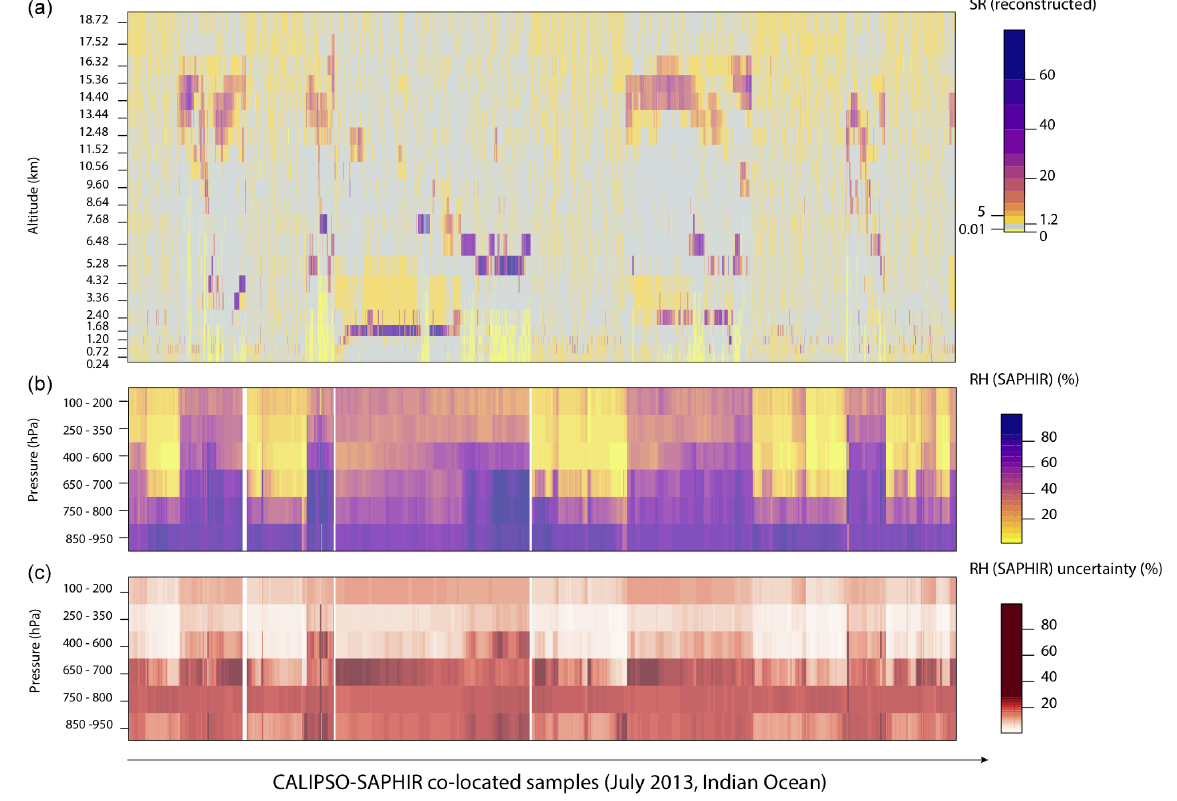
Figure 2. Reconstructed SR profiles for a selection of CALIPSO samples in the Indian Ocean, July 2013 (a) , and co-located RH observations from SAPHIR (mean and uncertainty (standard deviation), b and c ). As in Chepfer et al. (2010), SR > 5 correspond to cloudy observations, 0 < SR < 0 . 01 (light yellow) correspond to fully attenuated observations, 0 . 01 < SR < 1 . 2 (grey) correspond to clear sky, and 1 . 2 < SR < 5 (dark yellow) correspond to unclassified observations. Note that the reconstructed SRs were only used for layers indicating clouds to avoid mixing of cloud and clear-sky values. The x axis represents the co-location index. Overall, RH measurements with a standard deviation larger than 30% might be considered very